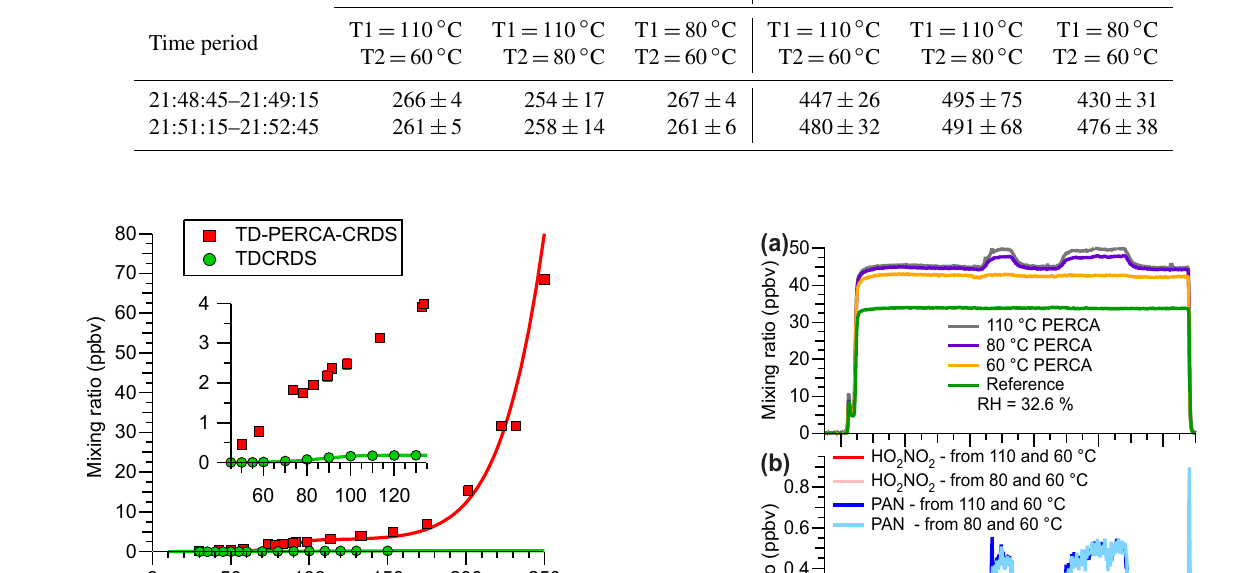
Table 6. Statistics (average ± 1standard deviation) of the 1s data shown in Fig. 12. PNA (pptv) PAN (pptv)